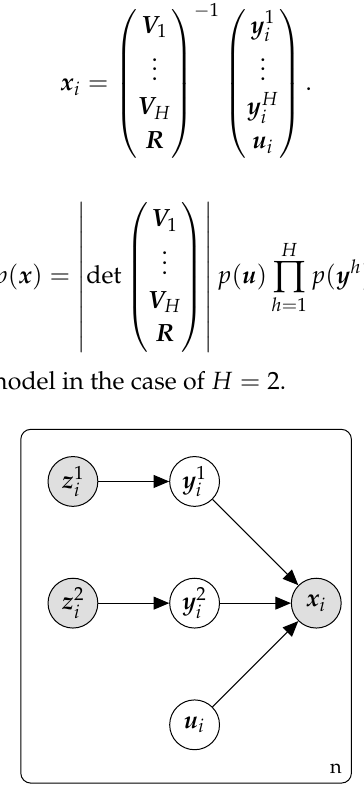
Figure 2. Adapted Bayesian dependency graph to the multi-partition setting, for H = 2 clustering